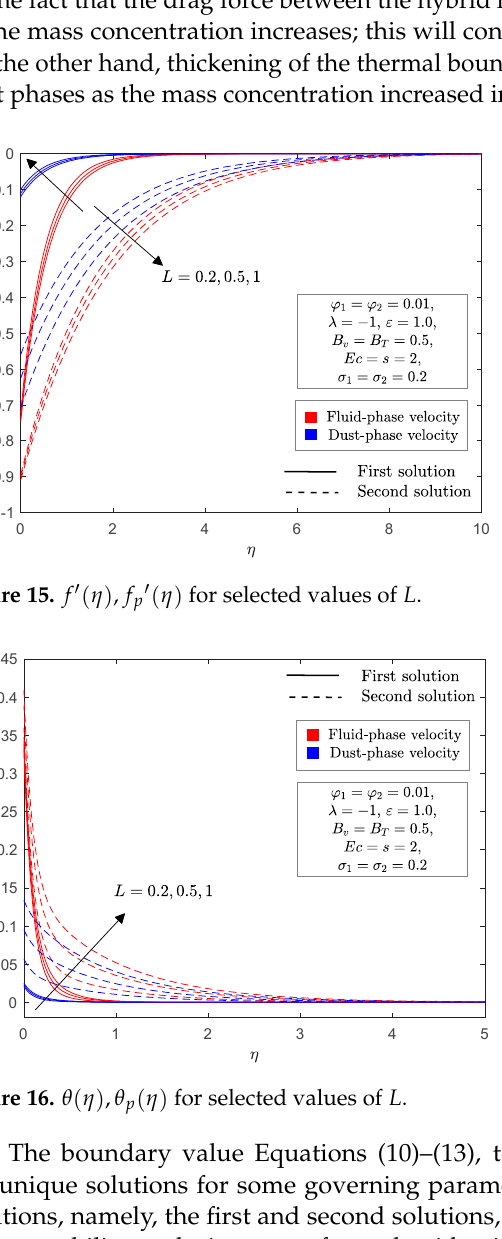
Figure 16. Figure 16.